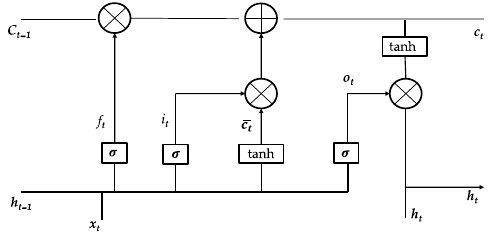
Figure 4. Architecture of the LSTM cell.